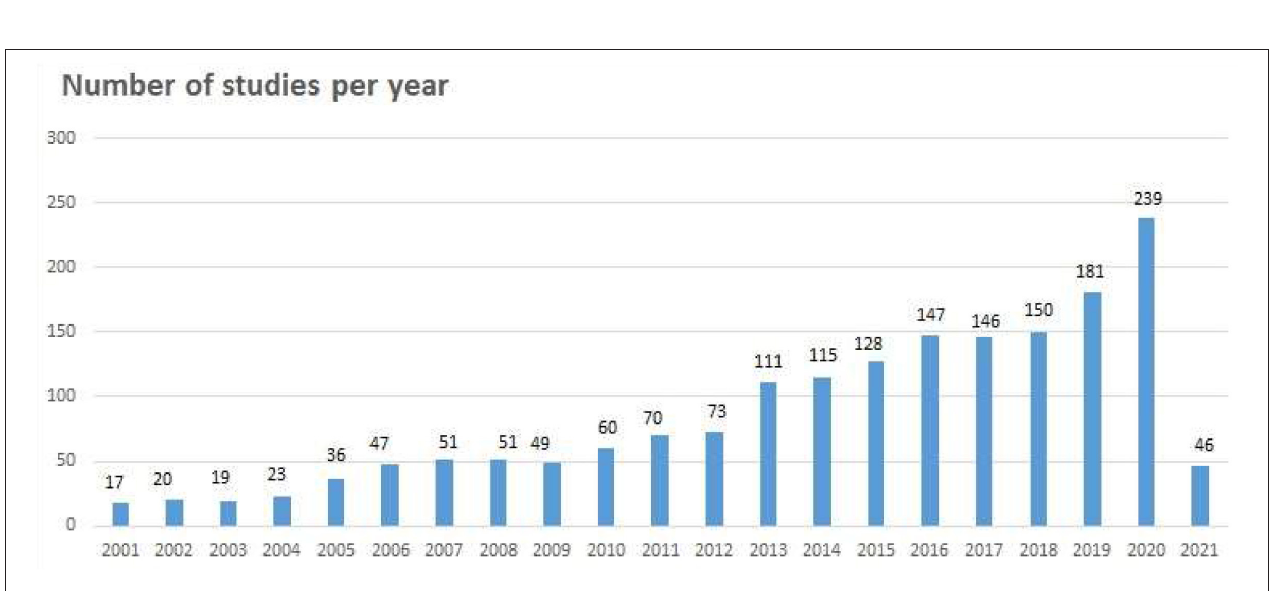
FIGURE 5 | Number of studies per